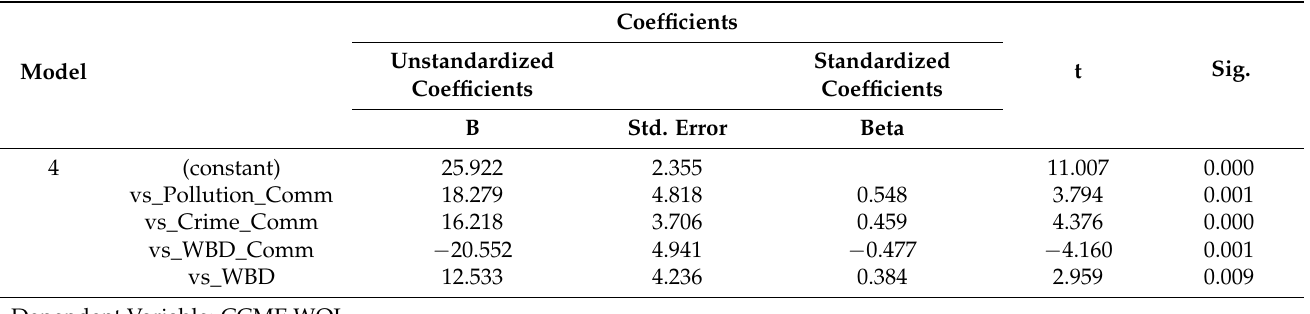
Table 5. Coefficients from the results of forward regression of CCME WQI versus parameters of household and community health, evaluated at all 22 sampling